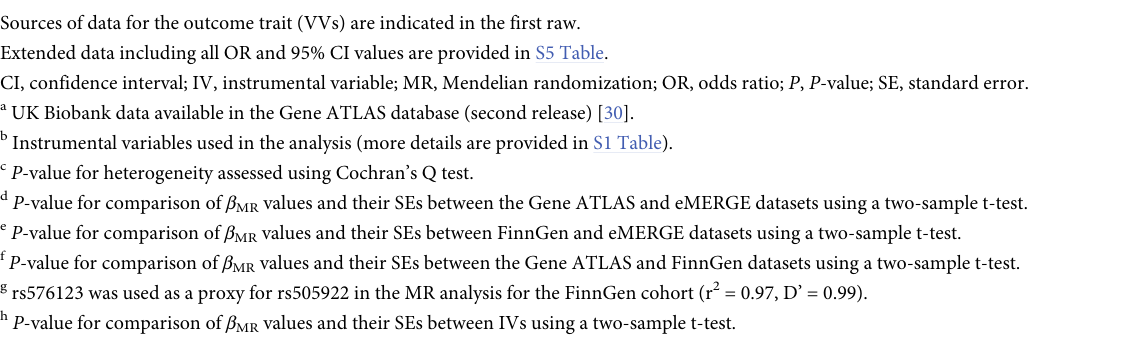
Two-sample t-test (comparison of β MR and their